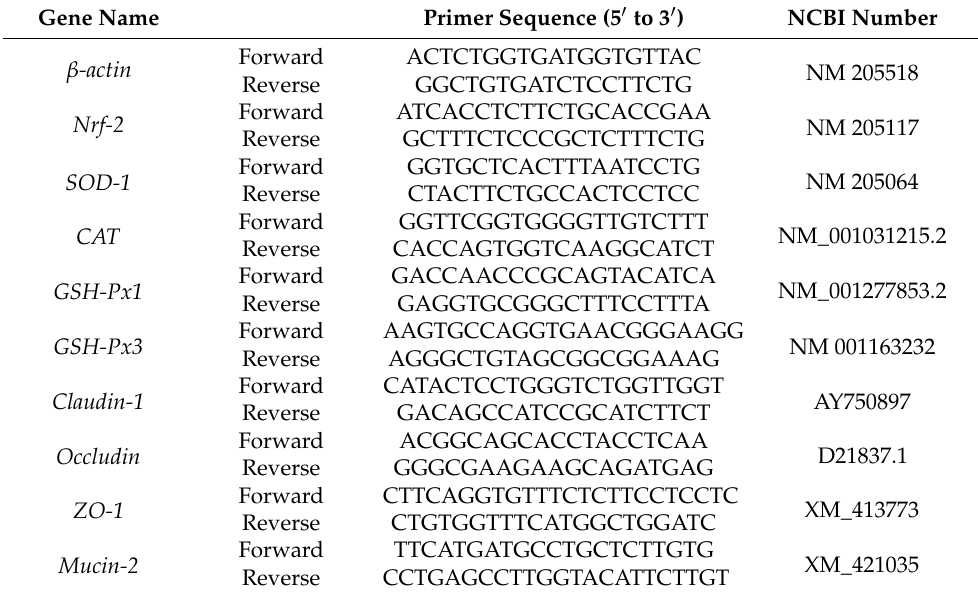
Table 2. The primer sequences list 1 .